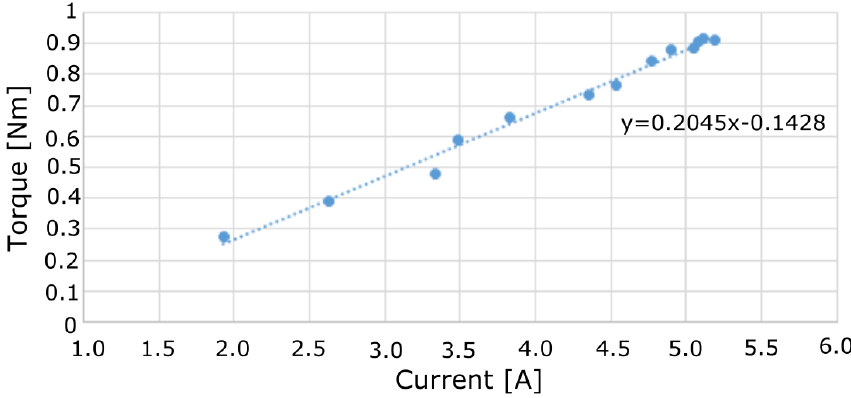
Figure 9. The torque measured at the output shaft of the DC motor with respect to the current fed